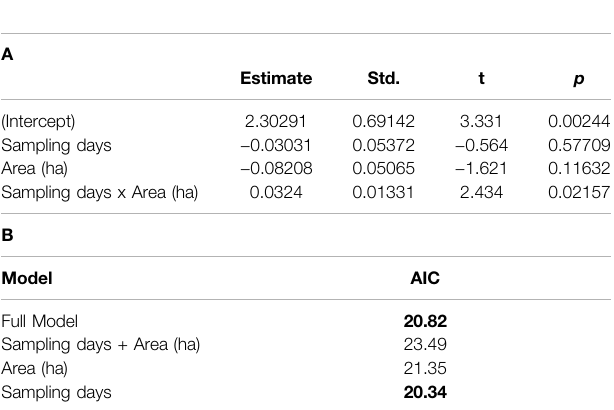
TABLE 4 | Regression table a. and model selection and b. for RTE ~ Sampling days+Area(ha)+SamplingdaysxArea(ha).F=3.81,DF=3,38, p =0.02,r 2 adj = 0.2138.